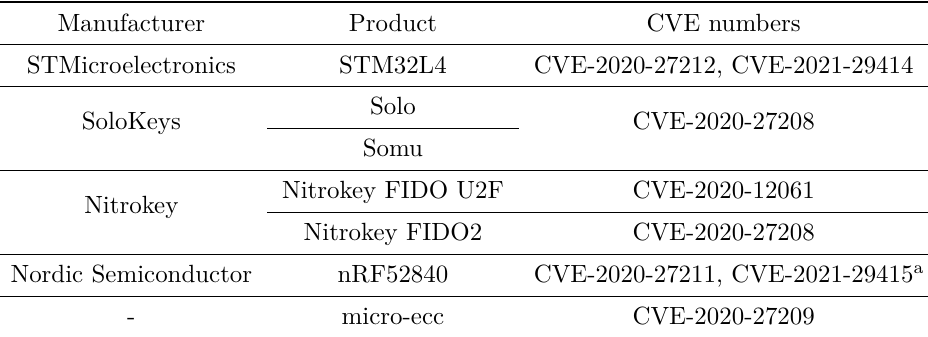
Table 4: Assigned CVE numbers for each vulnerability identified in this work.